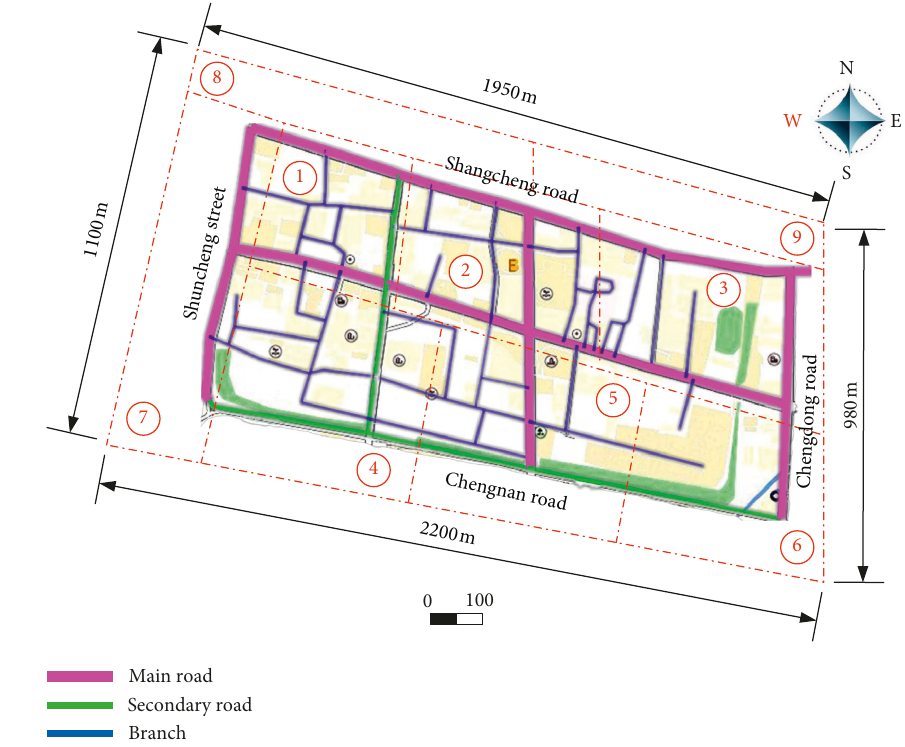
Figure 3: The division of the traffic areas of Academy